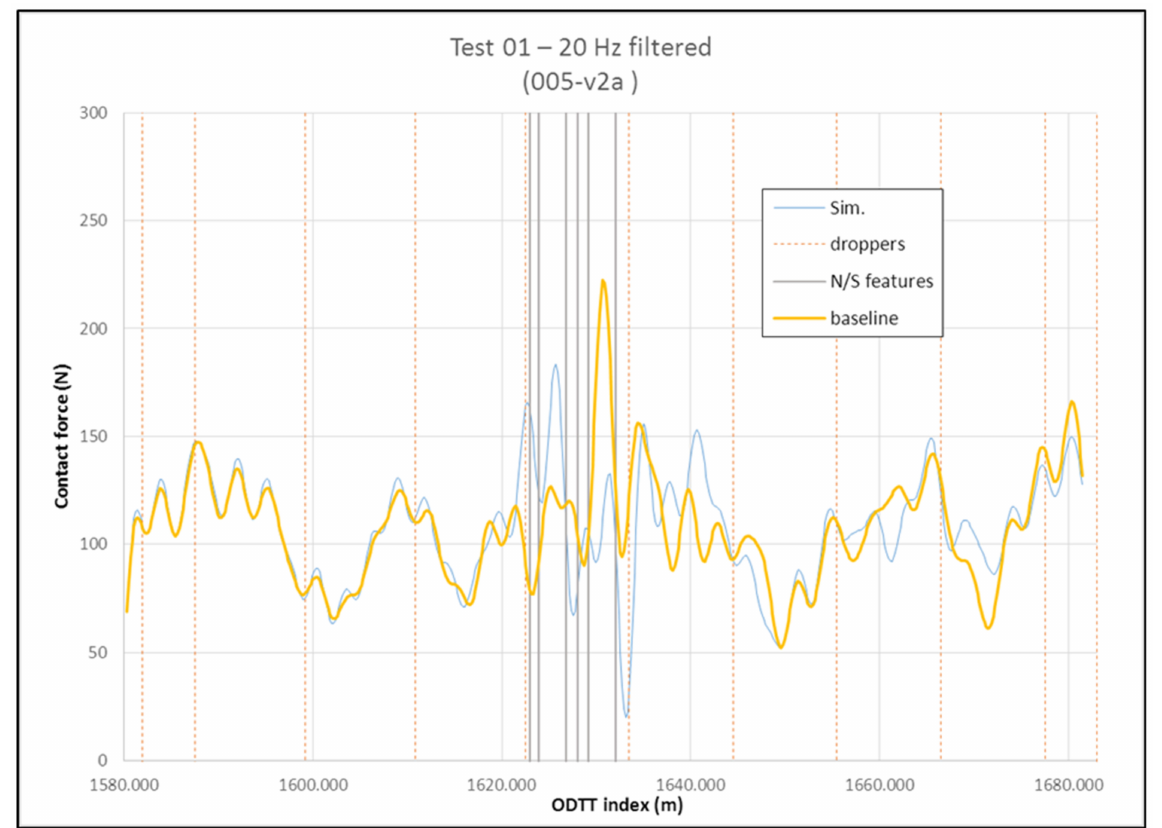
Figure 18. Parametric test 1 output data (20 Hz), compared to baseline.